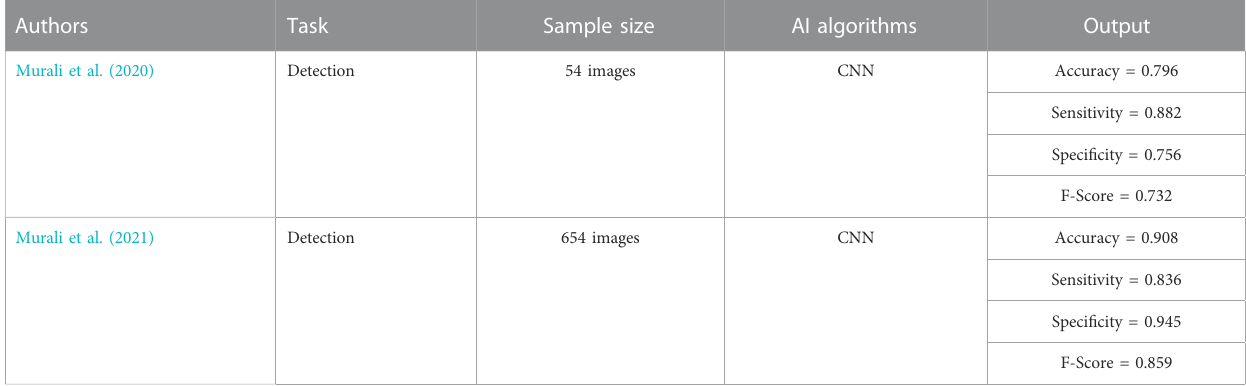
TABLE 5 Application summary of different AI models and algorithms in amblyopia.